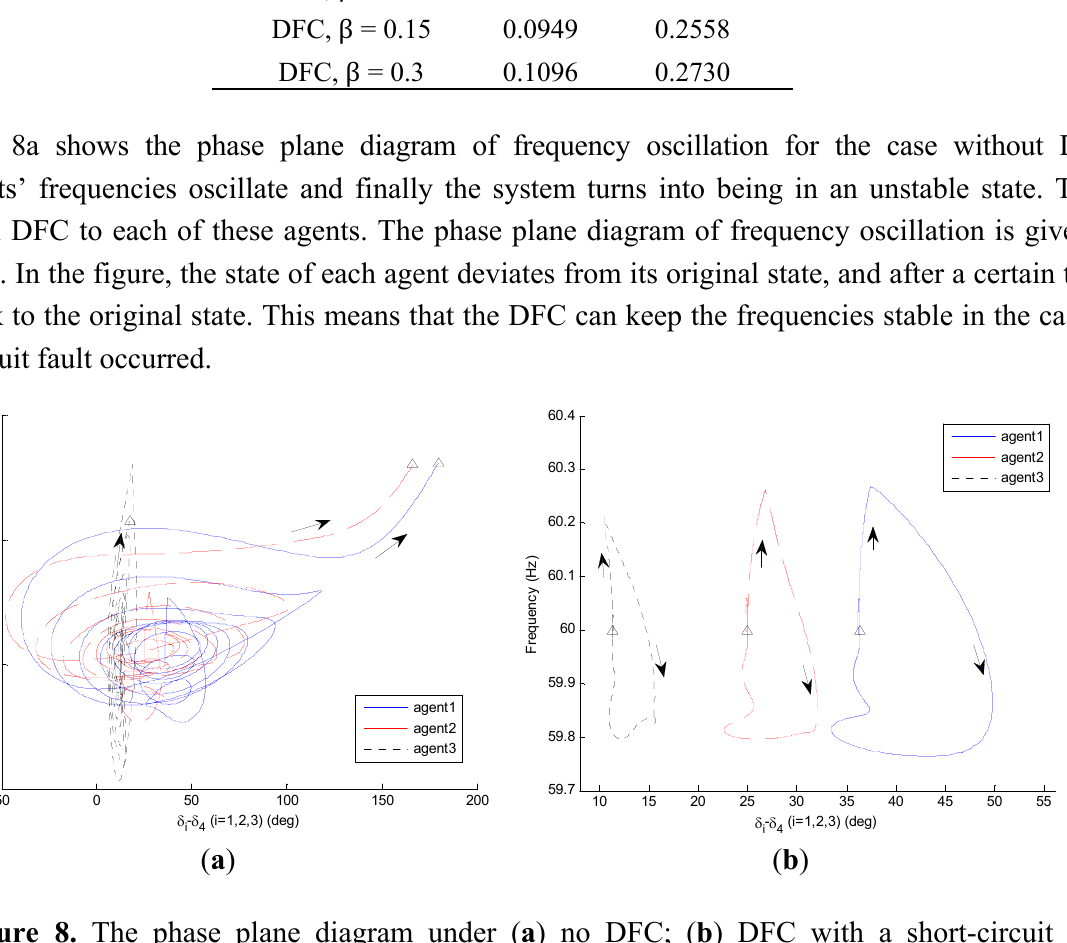
Figure 8. The phase plane diagram under ( a ) no DFC; ( b ) DFC with a short-circuit fault